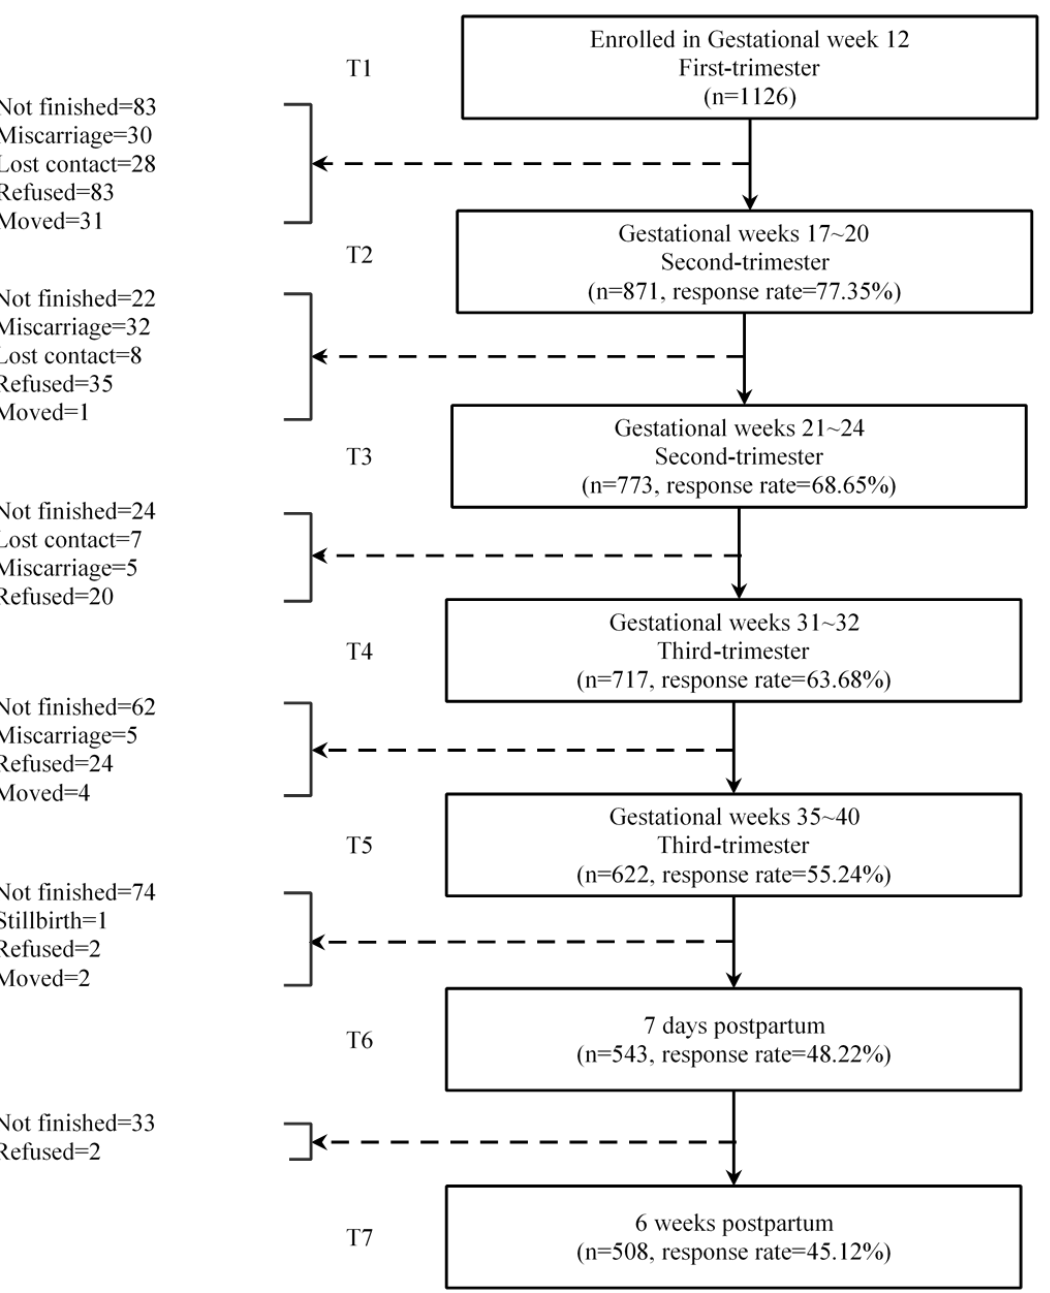
Figure 1. Flow chart of the cohort study.